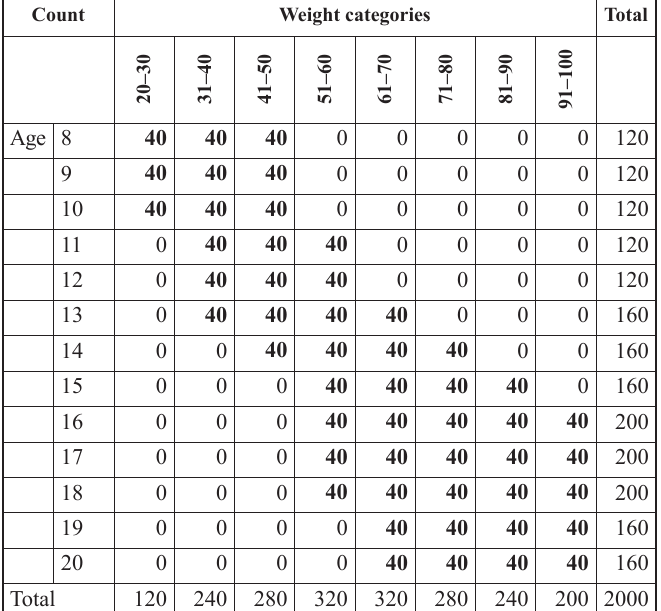
Table 1. Cross tabulation of age and weight